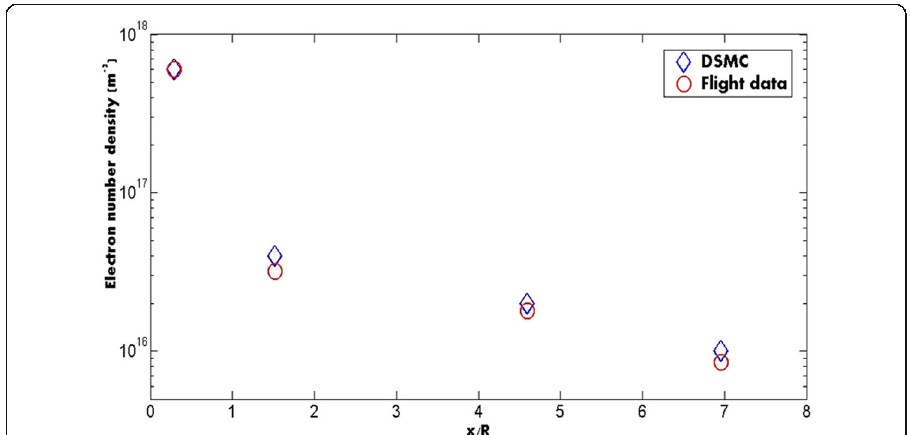
Fig. 9 The maximum electron number density comparison at the probe locations for RAM-C II at 81